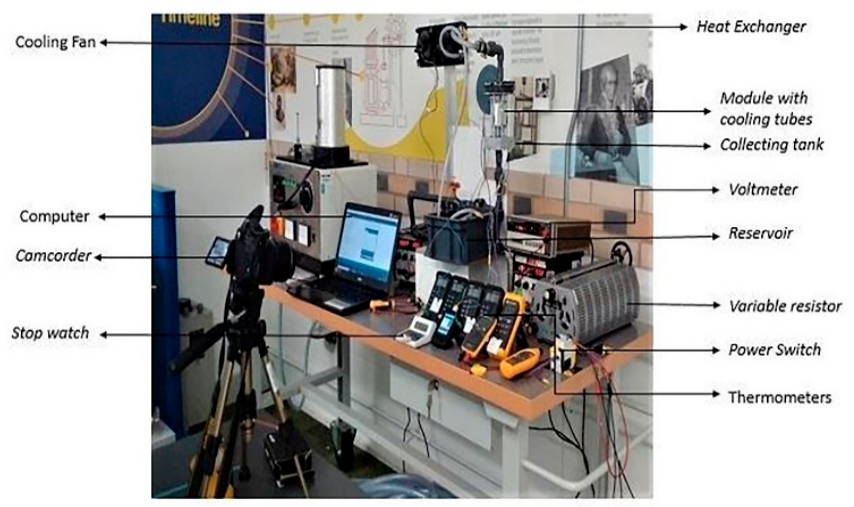
Figure 9. The experimental set up for the wet and dry cell module discharges.